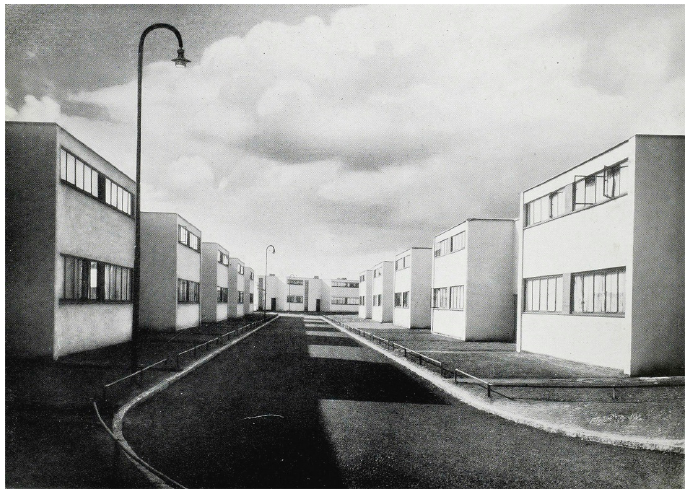
Figure 15. Walter Gropius: Dessau-Törten Housing, 1926–1928—Houses of the type built 1928. Image from (Gropius 1930, p. 190).